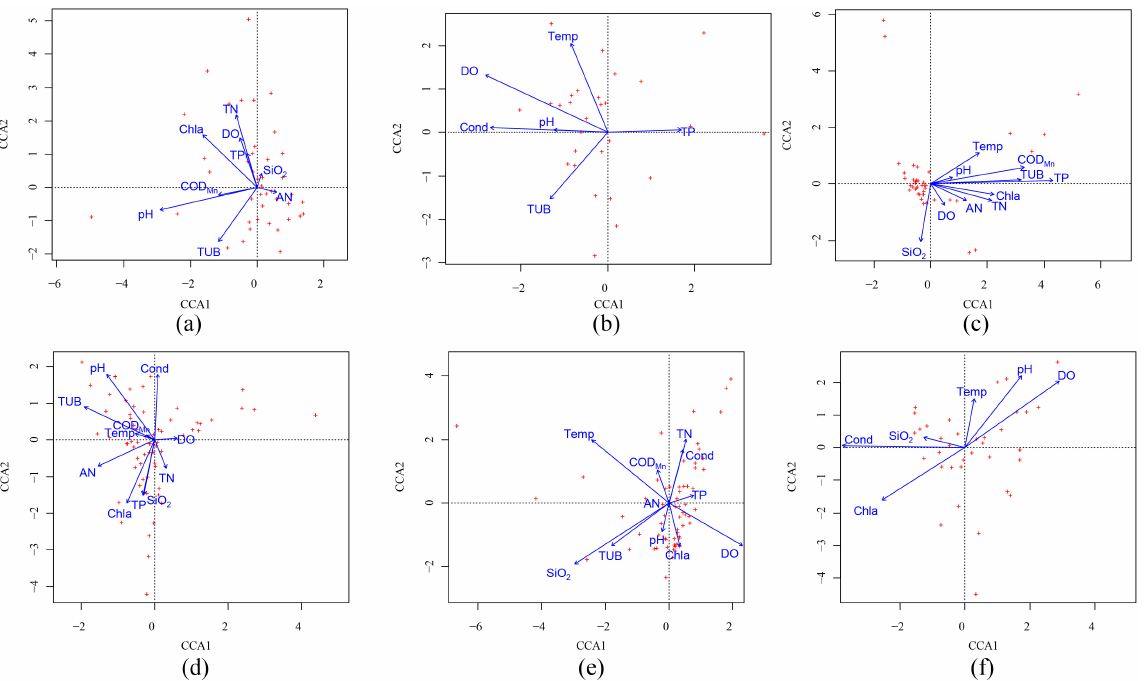
Figure 4. Canonical correspondence analysis (CCA) showed the relationship of the periphytic algae community and environment variable in each inflow river. ( a ) Chaohu inflow river; ( b ) Dianchi inflow river; ( c ) Danjiangkou inflow river; ( d ) Dongtinghu inflow river; ( e ) Poyanghu inflow river; ( f ) Taihu inflow